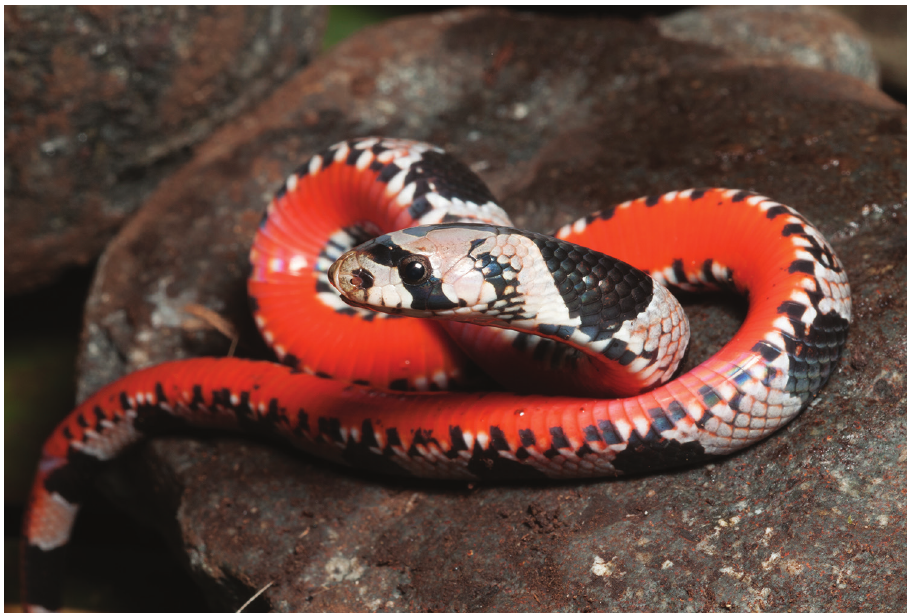
Figure 70. Oligodon maculatus juvenile (KU 334450) from Eye Falls, Mt. Hilong-hilong, Municipality of Remedios T. Romualdez, Agusan del Norte Province Photo: